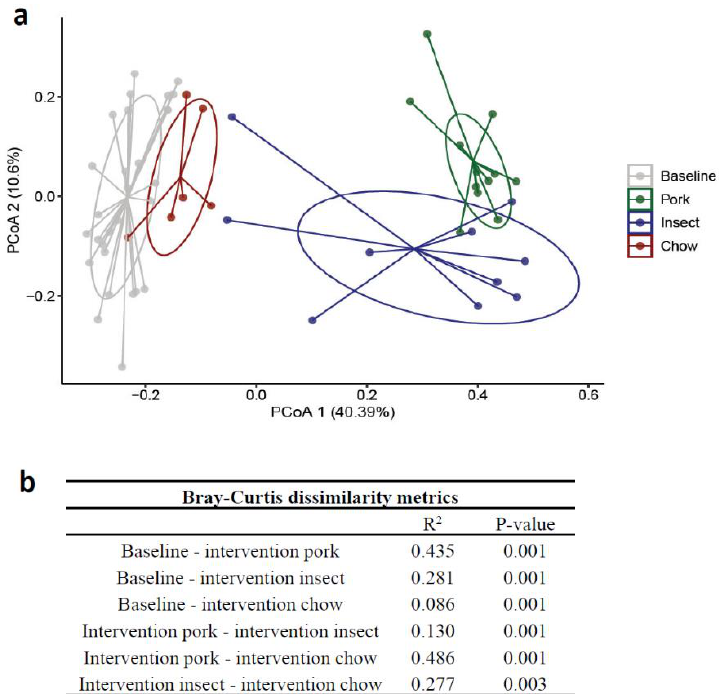
Figure 2. Beta diversity of the gut microbiota composition at baseline and after the three intervention diets. The gut microbiota composition was analyzed by 16S rRNA sequencing. PCoA plot of Bray- Curtis dissimilarity metrics of the gut microbiota composition comparing baseline (gray), pork sausage diet ( n = 12, green), insect-substituted pork diet ( n = 12, blue) or chow diet ( n = 6, red) group ( a ). Statistical values of Bray-Curtis dissimilarity metrics for all comparisons ( b ). The GM of the individual rats before and after intervention was examined (Figure 3).